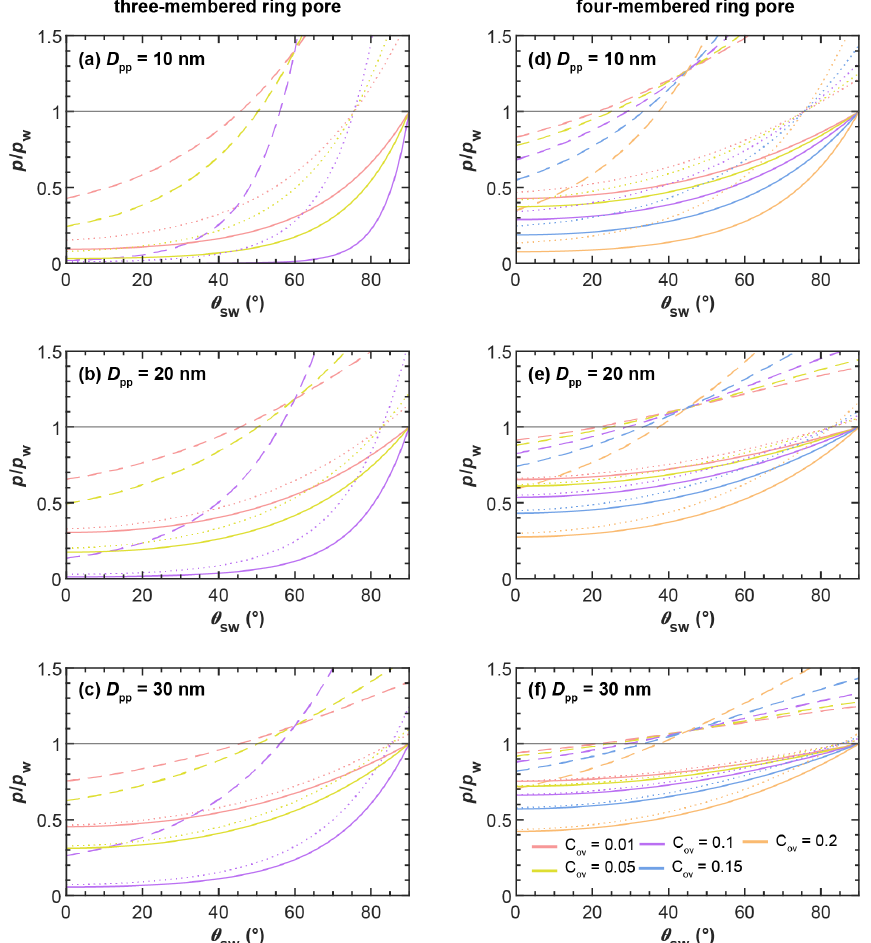
Figure 5. Pore-filling conditions for three-membered ring pores (tetrahedral packing, a , b , c ) and four-membered ring pores (cubic packing, d , e , f ) showing the saturation ratio with respect to water ( p/p w = S w ) required for filling of ring pores as a function of the soot–water contact angle ( θ sw ) at T = 220K. The different rows correspond to ring pores formed for spheres with different diameters ( D pp ). In each panel the S w needed for capillary condensation of water in the ring pore is compared for different filling mechanisms: slit filling up to ε = 30 ◦ (three-membered ring pore) and ε = 45 ◦ (four-membered ring pore) via pendular rings of water, followed by coalescence of water rings and complete filling of the ring pore is shown by the dashed lines. Direct filling of the ring pore neck is shown by the solid lines. Direct filling of the ring pore up to a height of h fr = 1 . 25nm, required for freezing, is shown by the dotted lines. The set of lines within each panel corresponds to different values for the overlap coefficient, C ov , as indicated in the legend. The expressions for the Kelvin equations describing the conditions for pore filling for the various filling mechanisms are given in Appendix